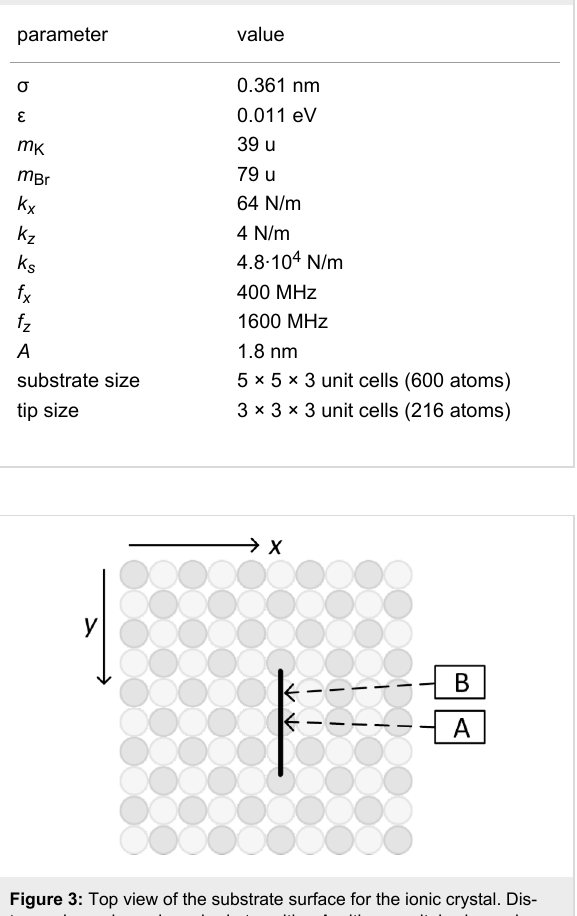
Table 2: Parameter set used for the ionic case.